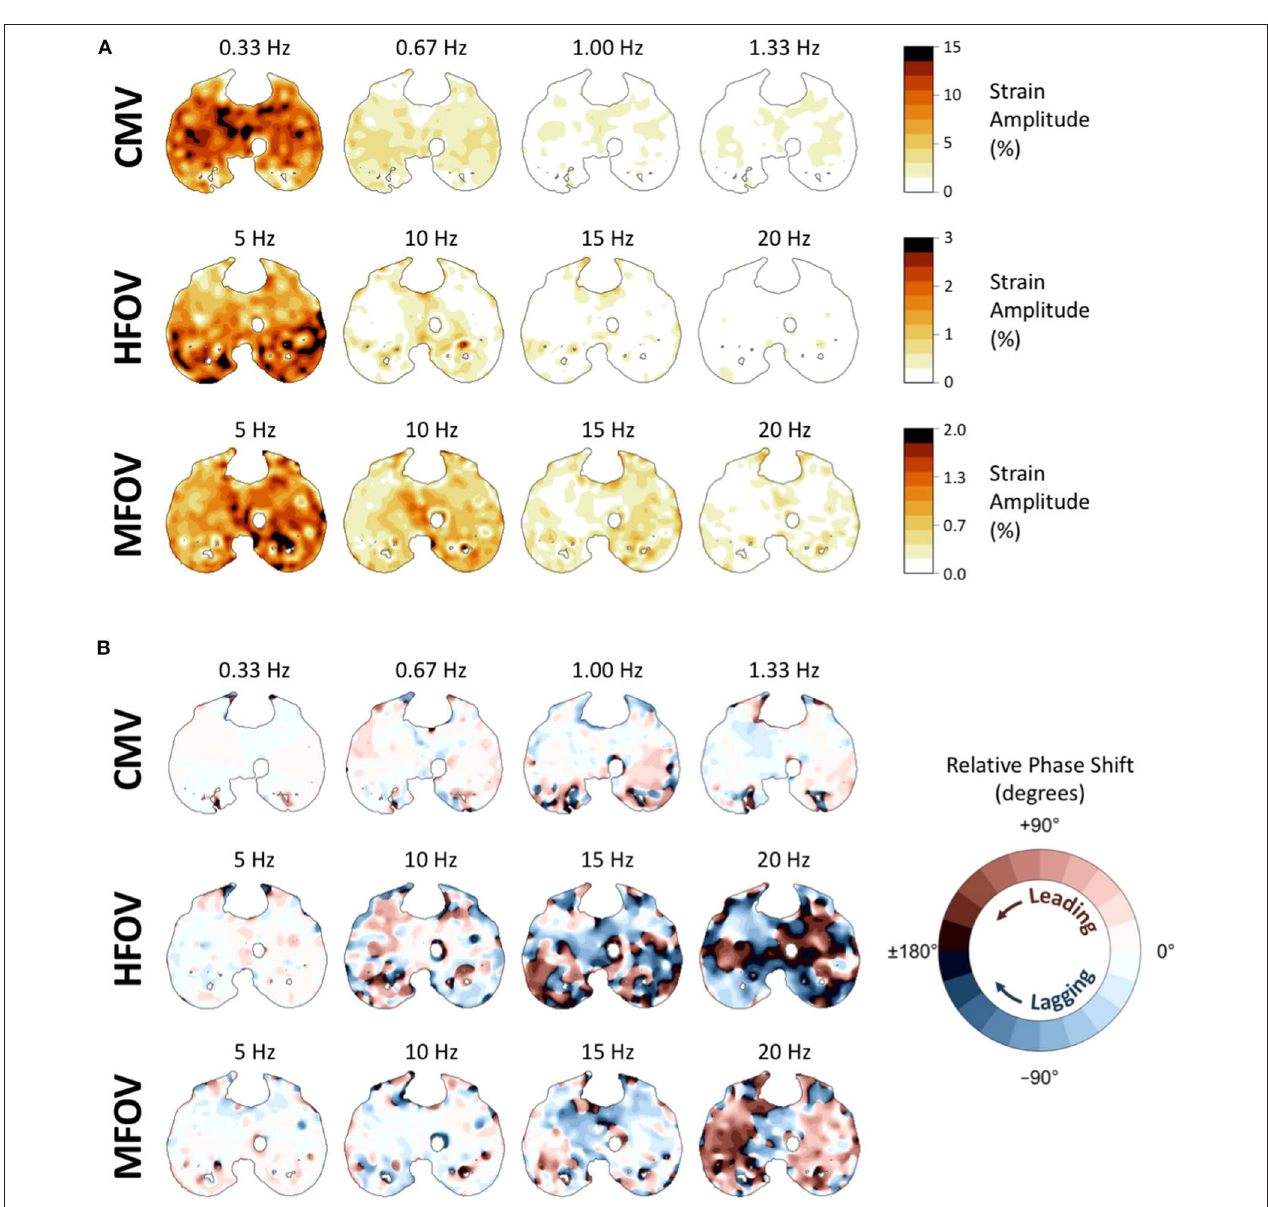
FIGURE 10 | Frequency-domain representations of tissue-correlated regional strain amplitude (A) and phase variations (B) in one subject during conventional mechanical ventilation (CMV), high-frequency oscillatory ventilation (HFOV), and multi-frequency oscillatory ventilation (MFOV). For each ventilation modality, strain amplitudes and phases were obtained from the discrete Fourier transform of time-varying Jacobian determinants within each voxel, using transformations mapped to a single reference image. In each cross-section of the reference image, voxel color in (A) indicates the strain amplitude at that frequency, corresponding to the amplitude of volumetric strain relative to the minimum volume of that particular voxel. Voxel color in (B) indicates the amount of phase shift (leading or lagging) relative to the median phase of all lung voxels at the specified